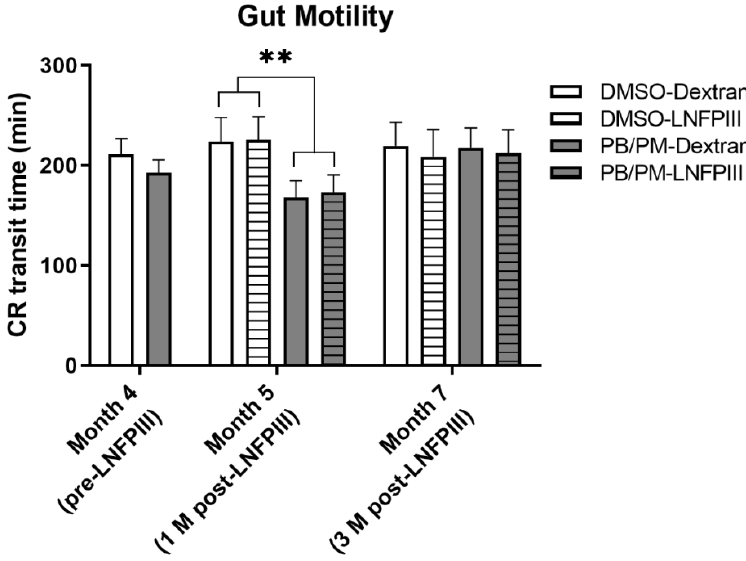
Figure 6. Bar plot showing gut transit time of carmine red (CR), 4, 5 or 7 months after mice were exposed to DMSO vehicle or PB/PM. Dextran vehicle or LNFPIII treatments started after CR testing at 4 months. Data are presented as mean ± SEM and sample sizes were n = 27–29/group at 4 months and n = 13–16 at months 5–7. (** p < 0.01).